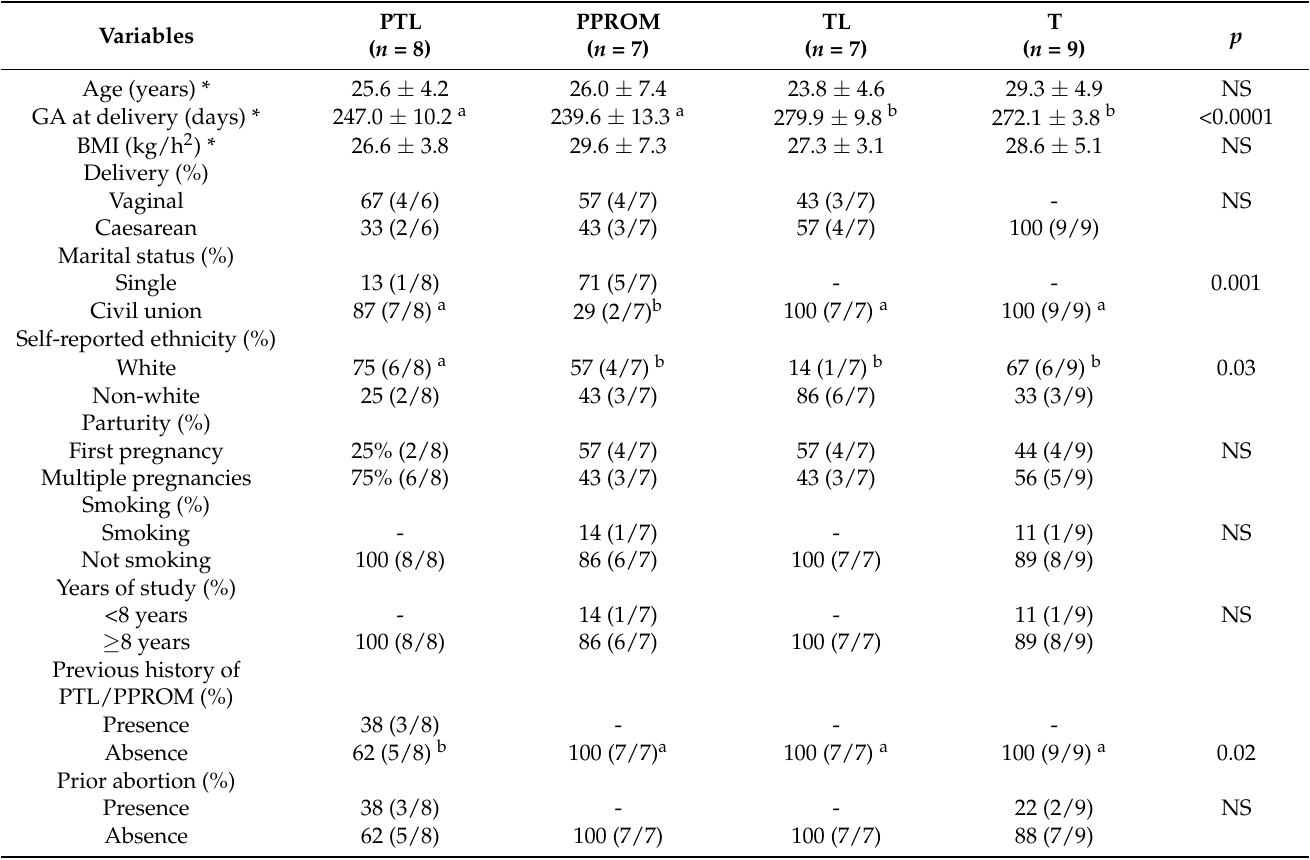
Table 1. Sociodemographic and clinical characteristics of women included in the study.